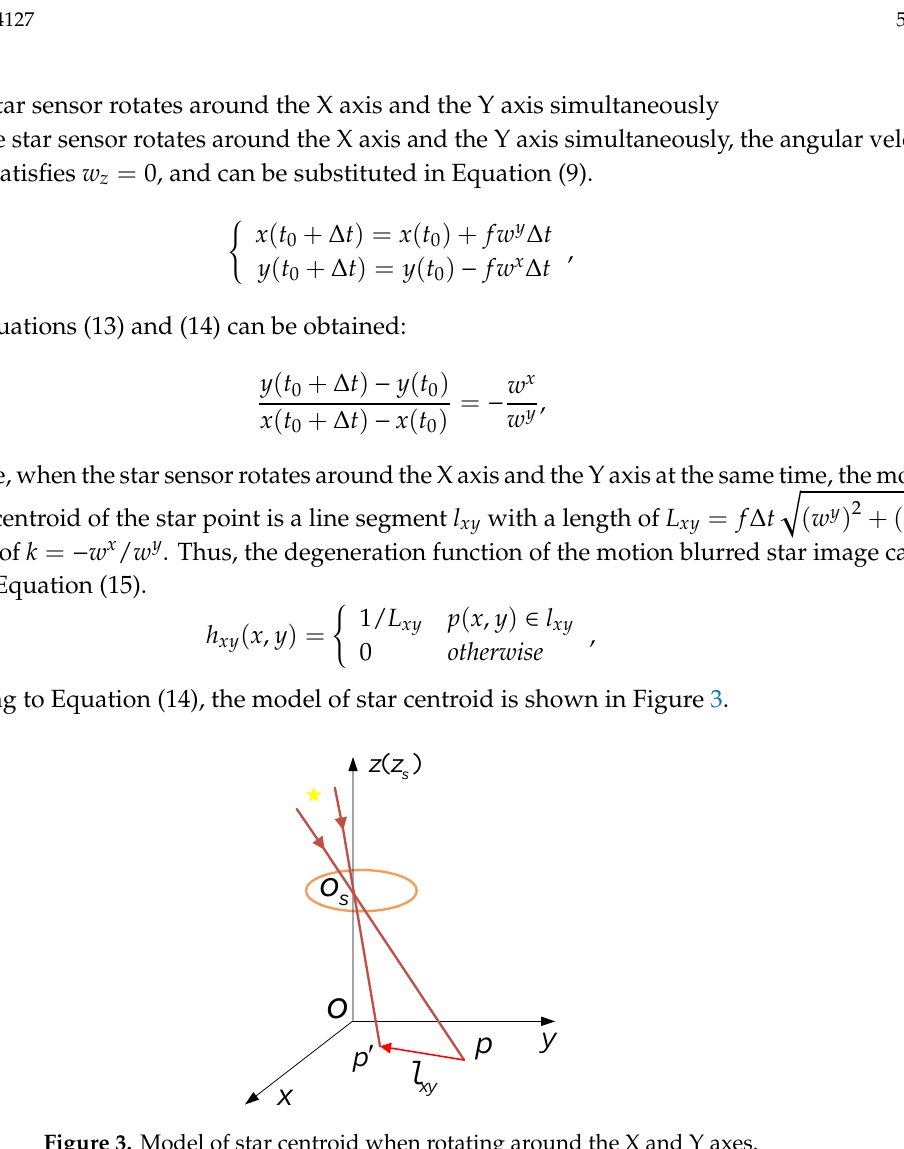
Figure 2. Model of star centroid when rotating around Z axis.